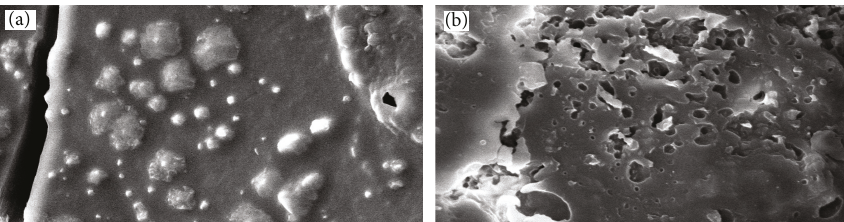
Figure 7: Scanning electron microscopy images of balangu seed powders with a magnification of 5000 × ; (a) the optimal sample (0.30% chitosan, 0.14% sodium alginate, and pH 3); (b) the worst sample including 1.5% chitosan, 0% sodium alginate, and pH